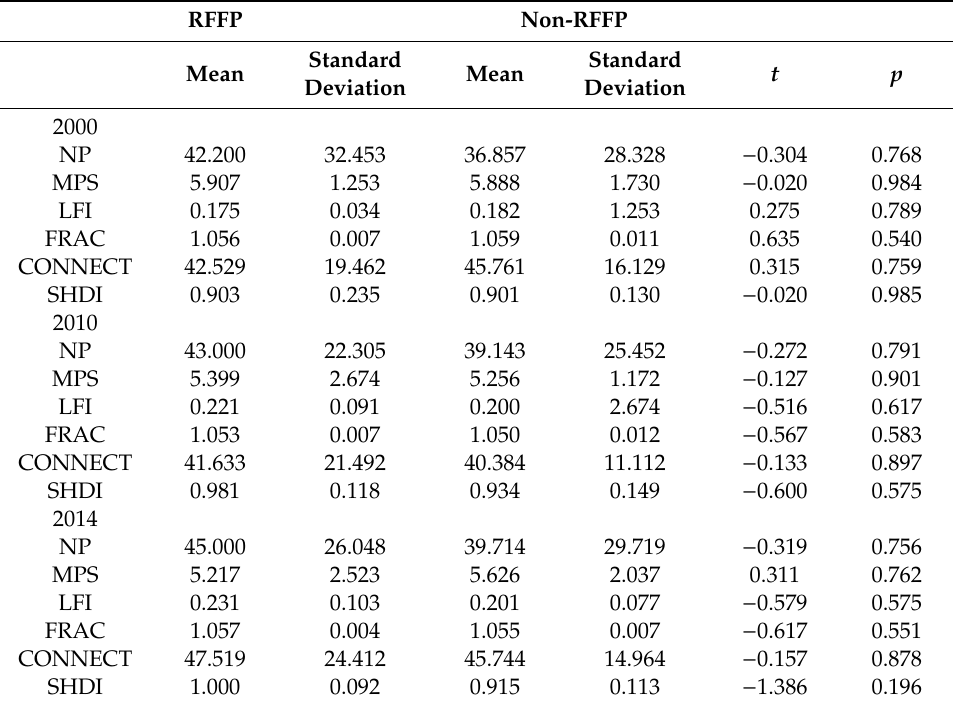
Refer to Table 3 for the abbreviations for landscape